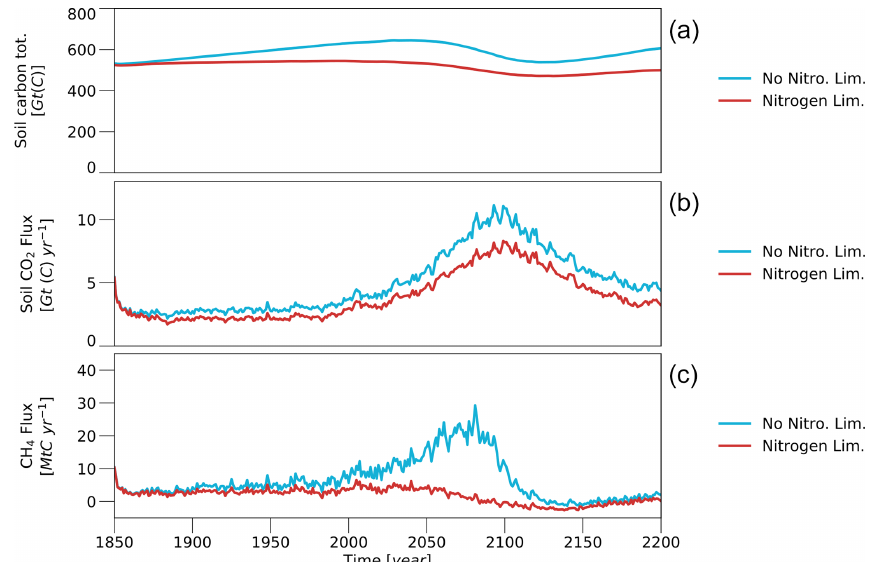
Figure A1. Nitrogen limitations. (a) Soil organic matter in permafrost-affected regions simulated with (red line) and without (blue line) accounting for nitrogen limitations. (b) Same as (a) but for the soil CO 2 fluxes. (c) Same as (a) but for soil methane emissions. Shown is the spin-up period and the scenario with a temperature peak in the year 2100.